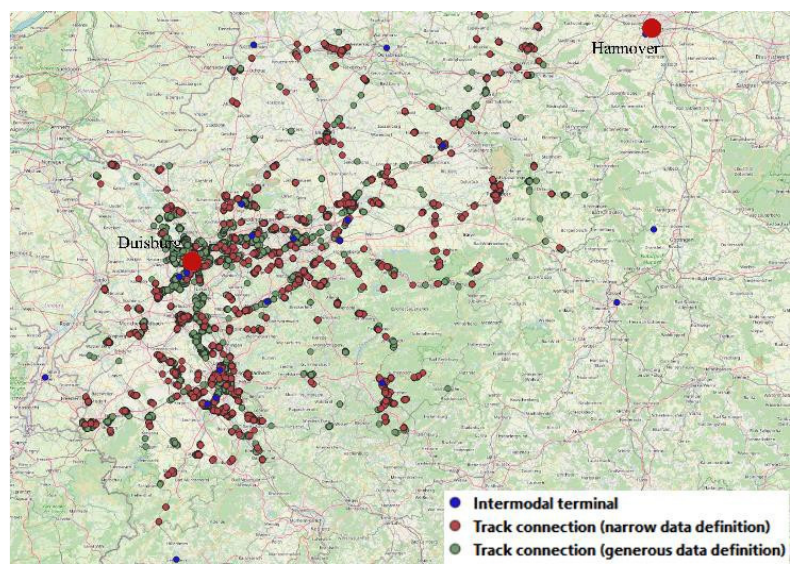
Figure 8. Locations of the rail infrastructure.